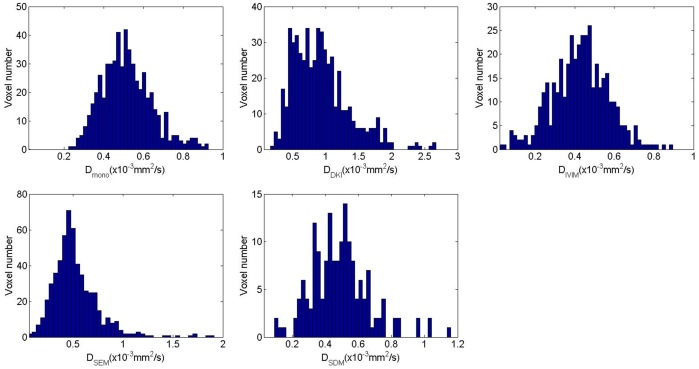
The histograms of the extracted voxel-wise diffusion coefficients based on the mono-exponential model (a), diffusion kurtosis model (b), intravoxel incoherent motion (c), stretched exponential model (d) and statistical diffusion model (e) from each model, i.e. Dmono, DDKI, DIVIM, DSEM and DSDM, within the ROIs of the primary tumor in Fig. 3.Non-Gaussian diffusion coefficients show differences from the mono-exponential ADC in value and distribution pattern. Note that the fitted values around zero for the statistical model were excluded in (e) for better visualization.